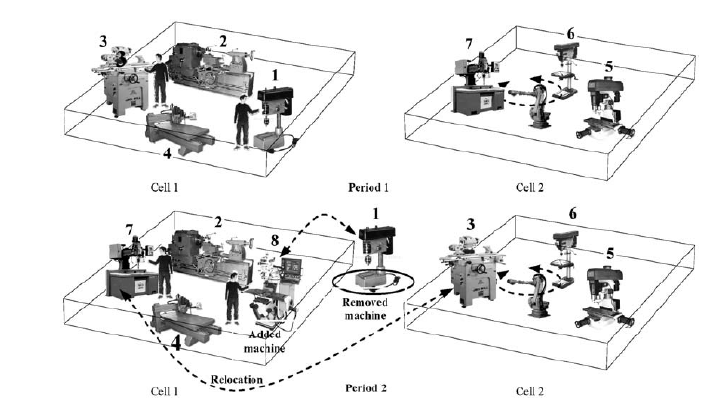
Fig. 1 . Intracellular and Intercellular Material